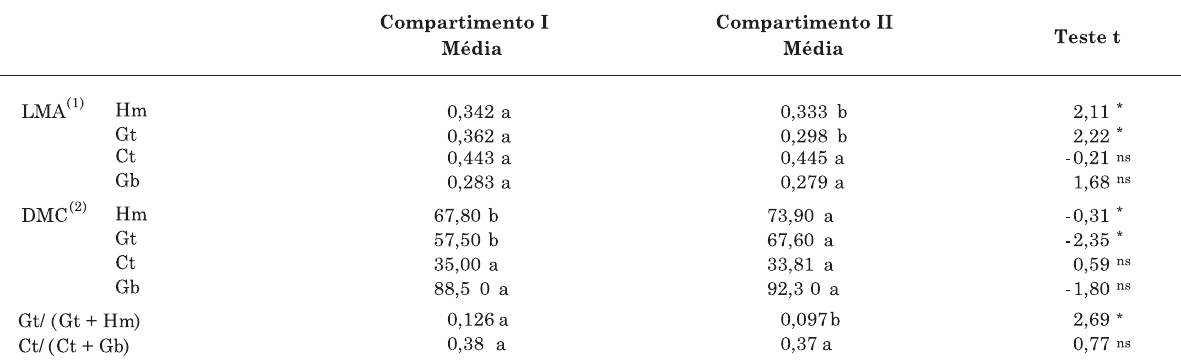
(1986) citaram os modelos esférico e exponencial como os mais